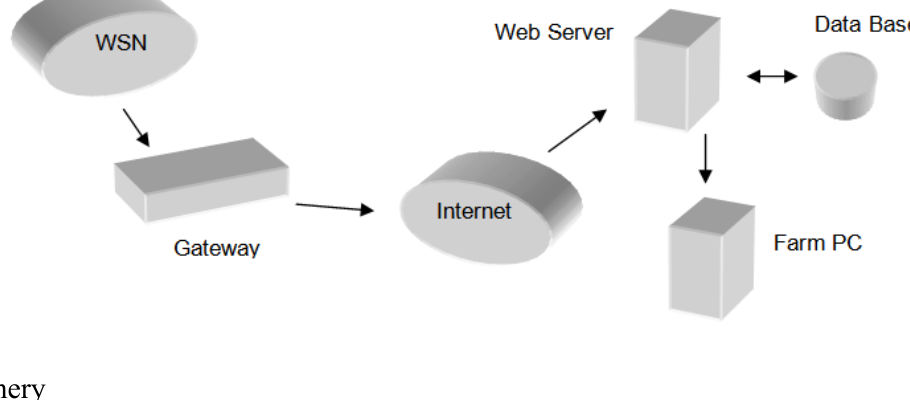
Figure 1. Proposal of remote sensing architecture in precision